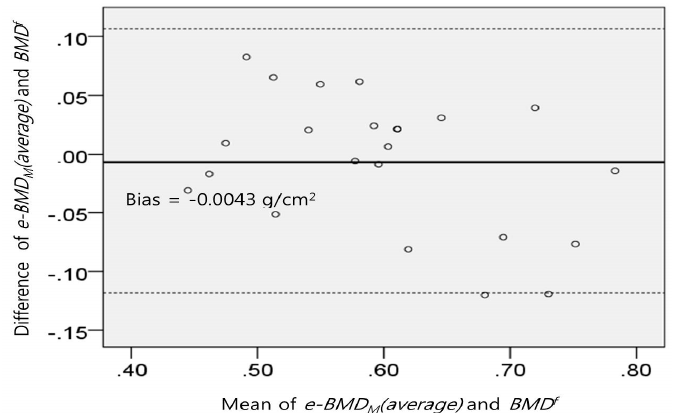
Figure 4. Bland–Altman plot: the mean of e ‐ BMD M ( average ) and BMD f versus the difference of e ‐ BMD M ( average ) and BMD f . Area bone mineral density derived from dual ‐ energy X ‐ ray absorptiometry (BMD DXA ) and computed tomographic images (BMD CBR ). e ‐ BMD M ( average ) systematically underestimates BMD f . The circle represents the difference of e ‐ BMD M ( average ) and BMD f for each sample. Solid and dash lines represent mean±1.96×standard deviation of the differences of e ‐ BMD M ( average ) and BMD f .